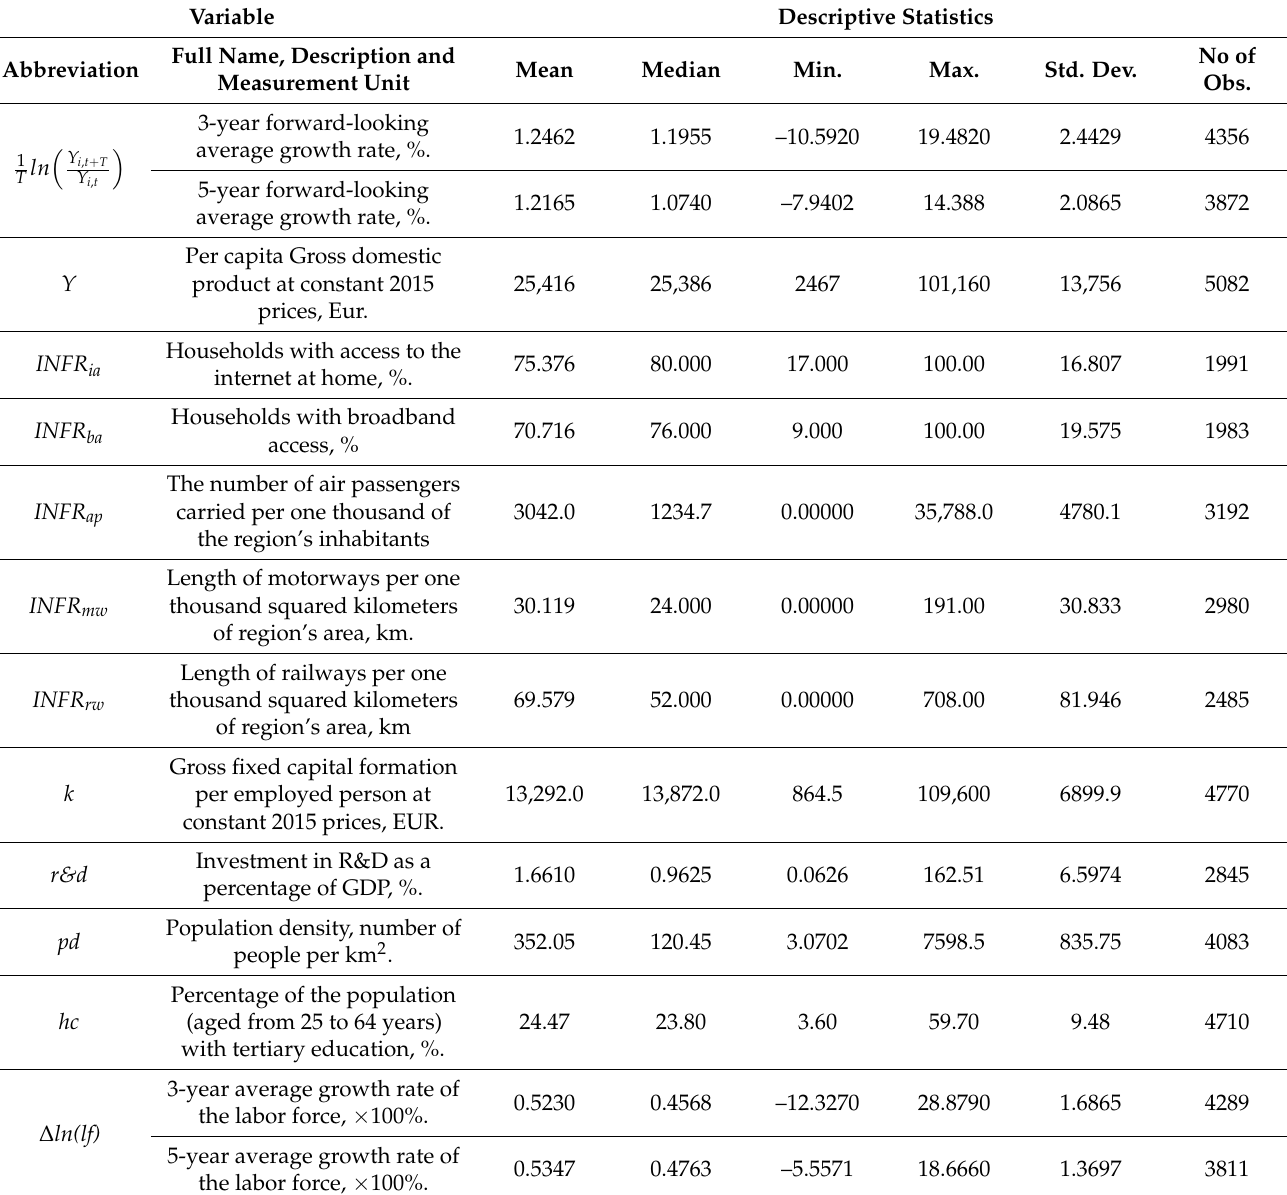
Table 1. Summary statistics of the